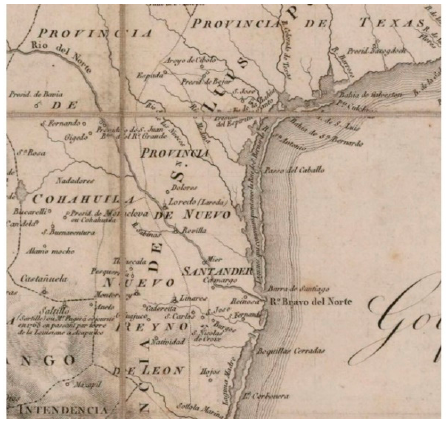
Figure 2. van Humbolt (1811) Texas Map.